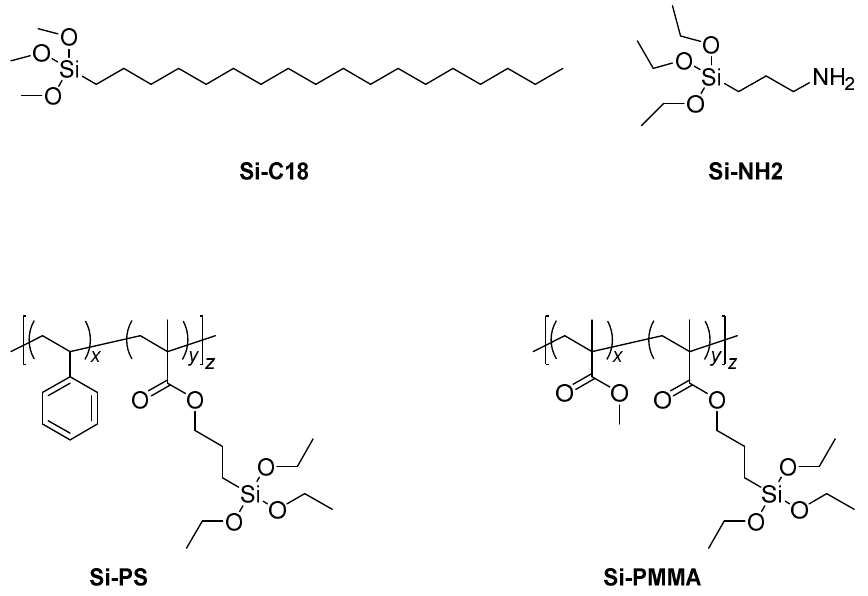
Figure 1. Schematic representation of the silane grafting agents used for the modification of hydroxylated h-BN.